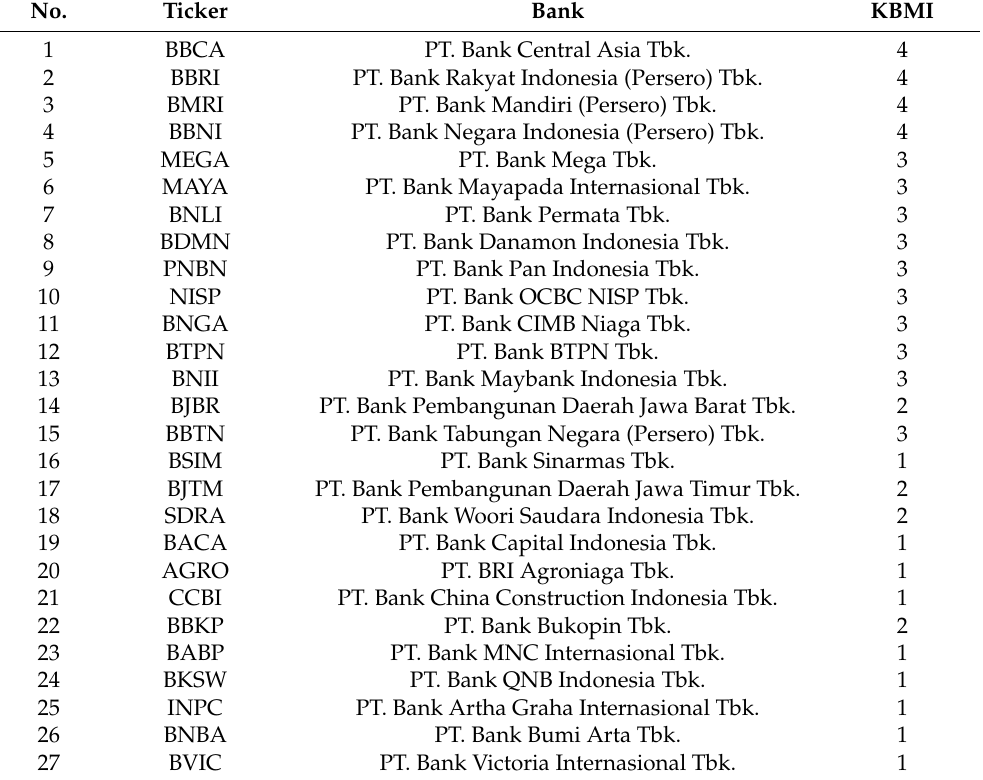
Table 2. Sample, Tickers, and